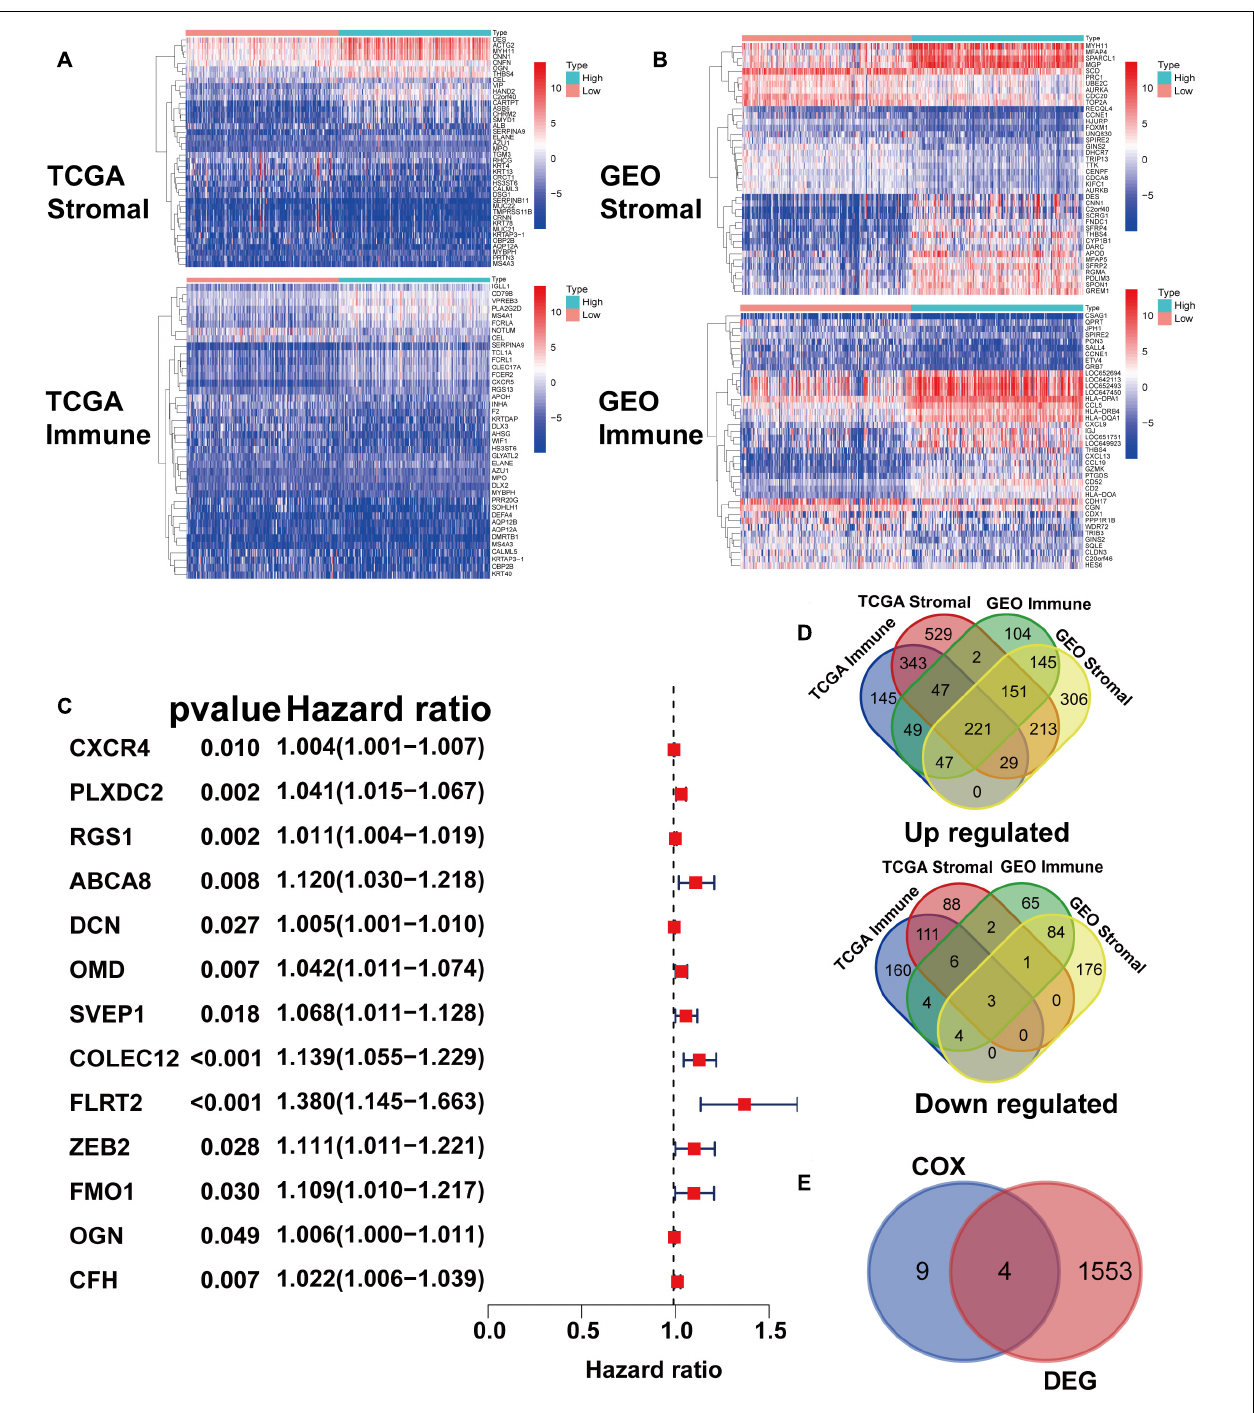
FIGURE 2 | Identification of prognostic gene markers according to patients’ stromal and immune scores. (A) Heatmaps of the top 20 DEGs generated by comparing the high stromal/immune score group and the low stromal/immune score groups of TCGA STAD patients. The heatmaps’ row name is the gene name, and the ID of the samples is the column name, which is not shown in the plot. DEGs were determined by the Wilcoxon rank sum test with q = 0.05 and | fold change| (FC) > 1 after log 2 transformation as the thresholds for significance. (B) Heatmaps of DEGs in GEO patients, similar to (A) . (C) Venn plots generated via an online tool (http://bioinformatics.psb.ugent.be/webtools/Venn/) depicting the up-regulated and down-regulated DEGs shared by the TCGA STAD and GEO datasets. (D) Forest plot of Cox regression (with 95% confidence interval), which was conducted with the 224 DEGs. (E) Venn plot depicting genes that were both related to survival and differentially expressed between tumor samples and normal samples.